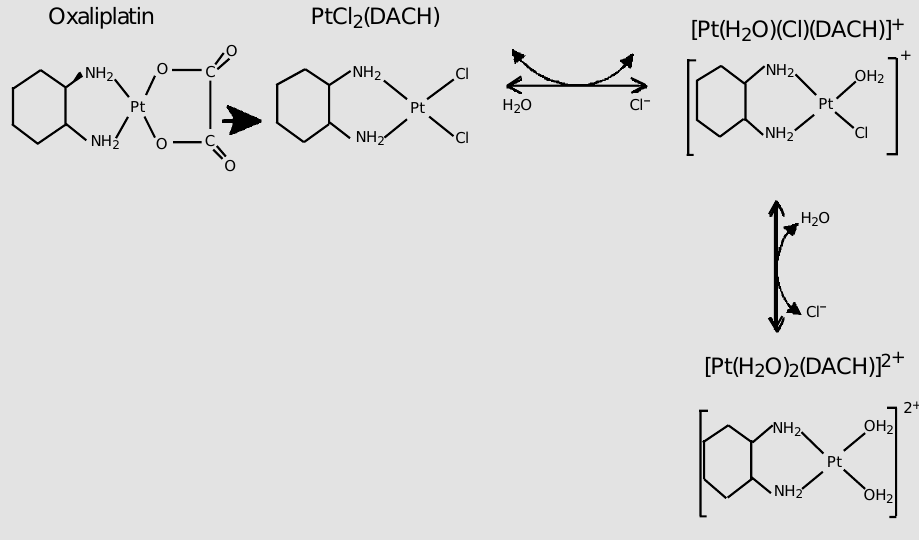
Figure 4. Oxaliplatin biotransfor- mation. DACH: diaminocyclo- hexane. Modified from Ref.